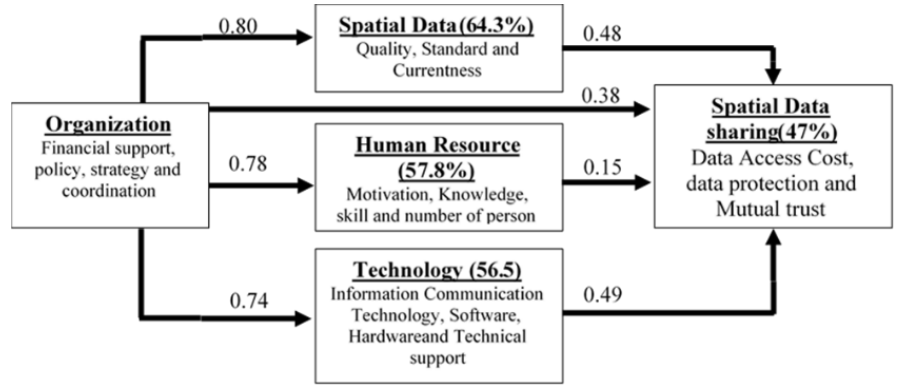
Figure 6. Level of correlation between variables in the structural model.